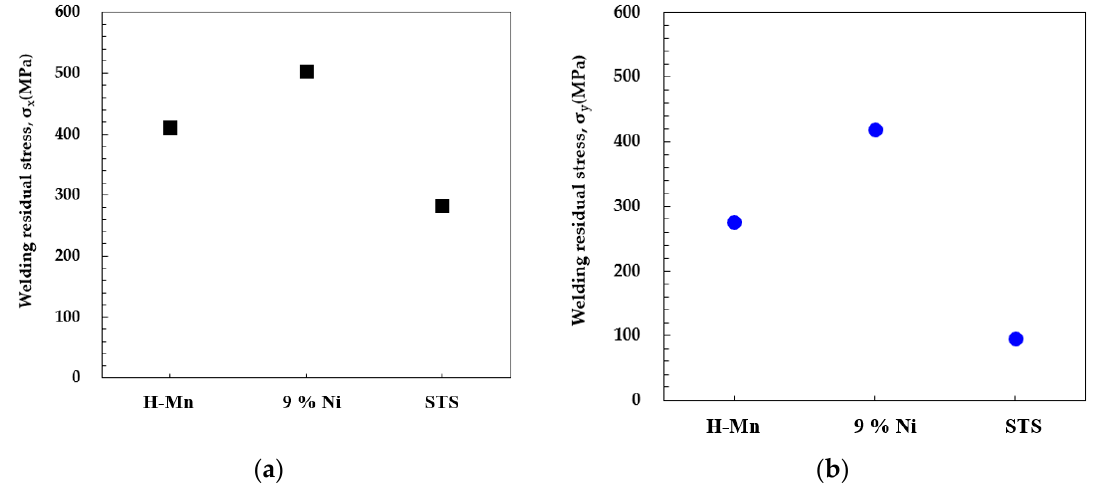
Figure 8. Welding residual stresses in the ( a ) weld line direction, i.e., σ x , and ( b ) transverse direction, i.e., σ y , for high-manganese austenitic steels, 9% Ni steel, and STS specimens prepared via the cutting method.